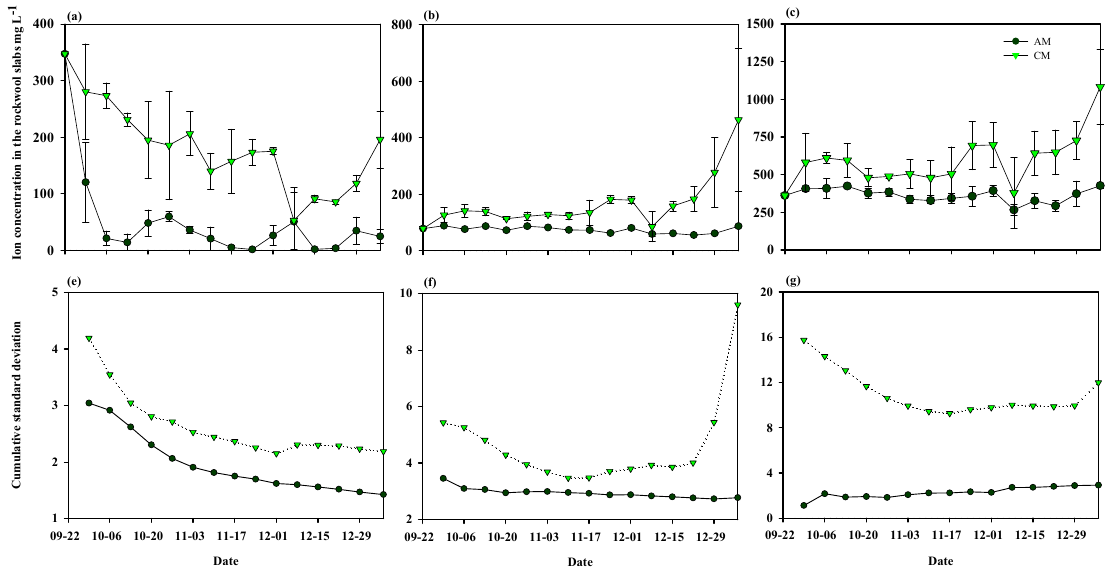
Figure 8. Changes in nutrient concentrations (mean ± SD) of K + ( a ), Mg 2 + ( b ), and Ca 2 + ( c ) and changes in cumulative standard deviation of nutrient concentrations of K + ( e ), Mg 2 + ( f ), and Ca 2 + ( g ) in the rockwool substrates using the conventional (CM) and alternative (AM) nutrient-replenishment methods, respectively.